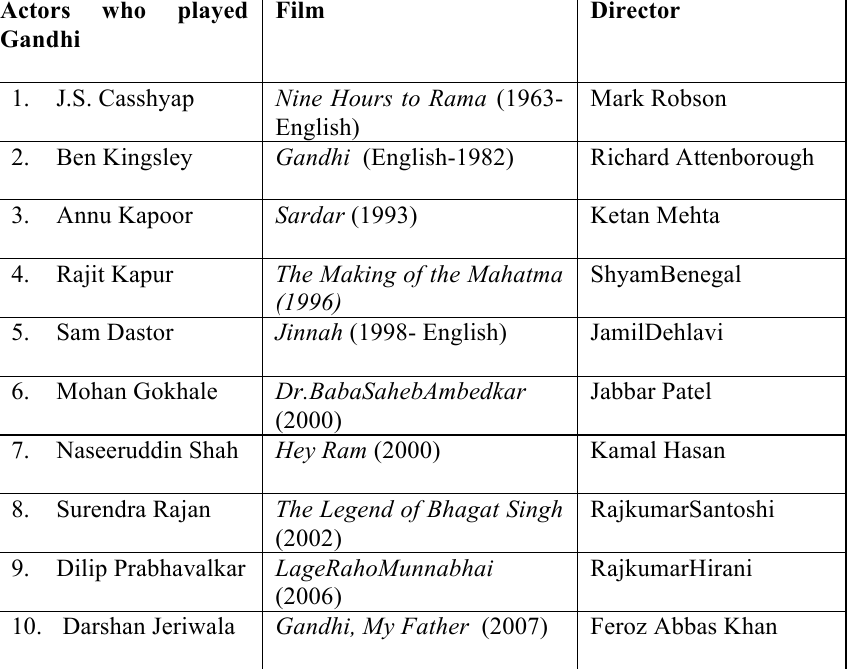
Table No.2: People who acted as Gandhi in various films of Gandhi